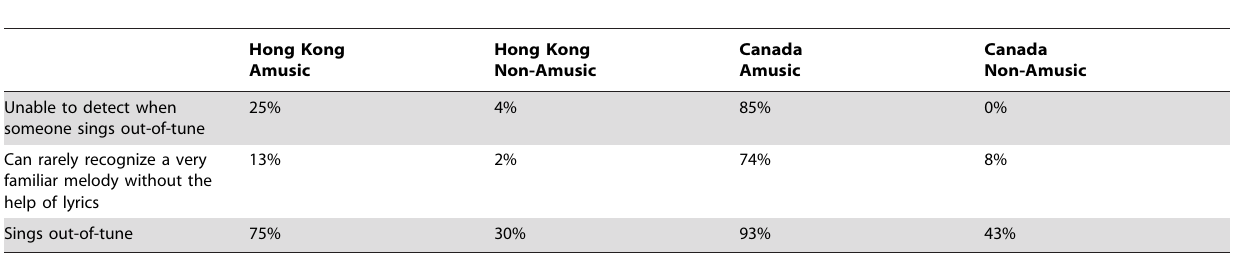
Table 3. Percentage of responses (proportion of participants) to questions relevant for the identification of amusic individuals.